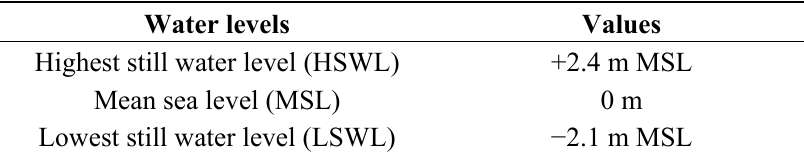
Table 1. Measured water levels at the IJmuiden